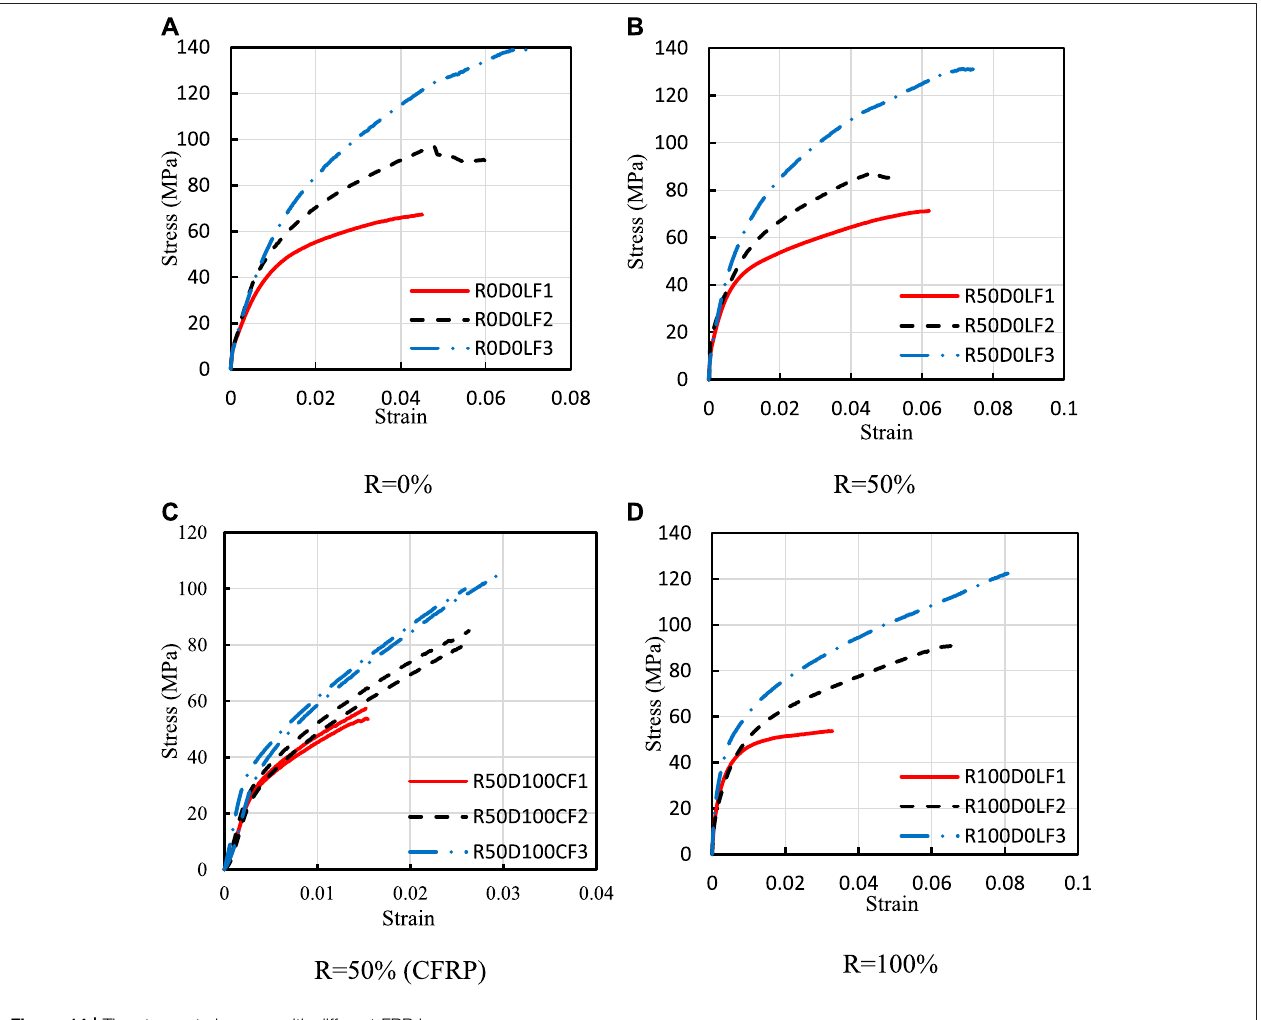
Figure 14 | The stress-strain curve with different FRP